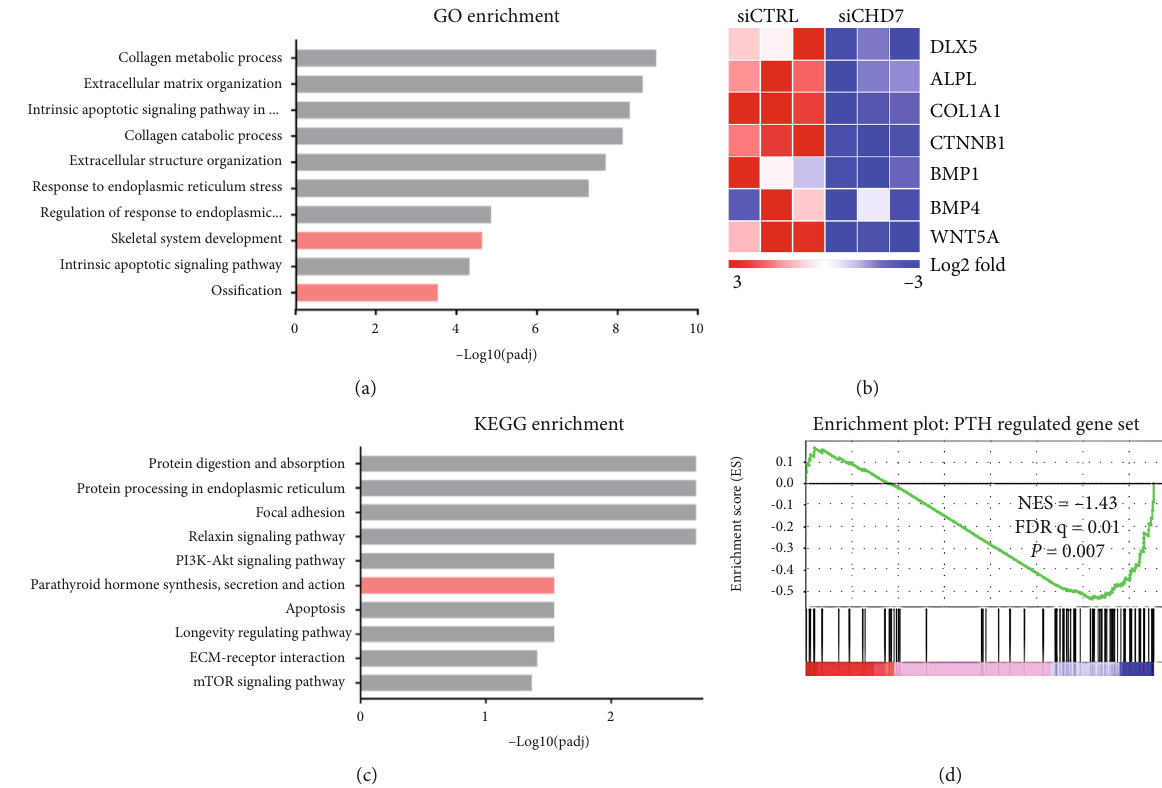
Figure 4: RNA-seq revealed the downregulated enrichment of the PTH-related pathway after CHD7 depletion. (a) GO enrichment unraveled that skeletal system development and ossi fi cation were suppressed after CHD7 depletion. (b) Heatmap of representative osteogenesis associated genes. (c) KEGG enrichment unraveled that the PTH-related pathway was signi fi cantly suppressed after CHD7 depletion. (d) GSEA showed decreased enrichment of PTH-regulated genes in CHD7-de fi cient